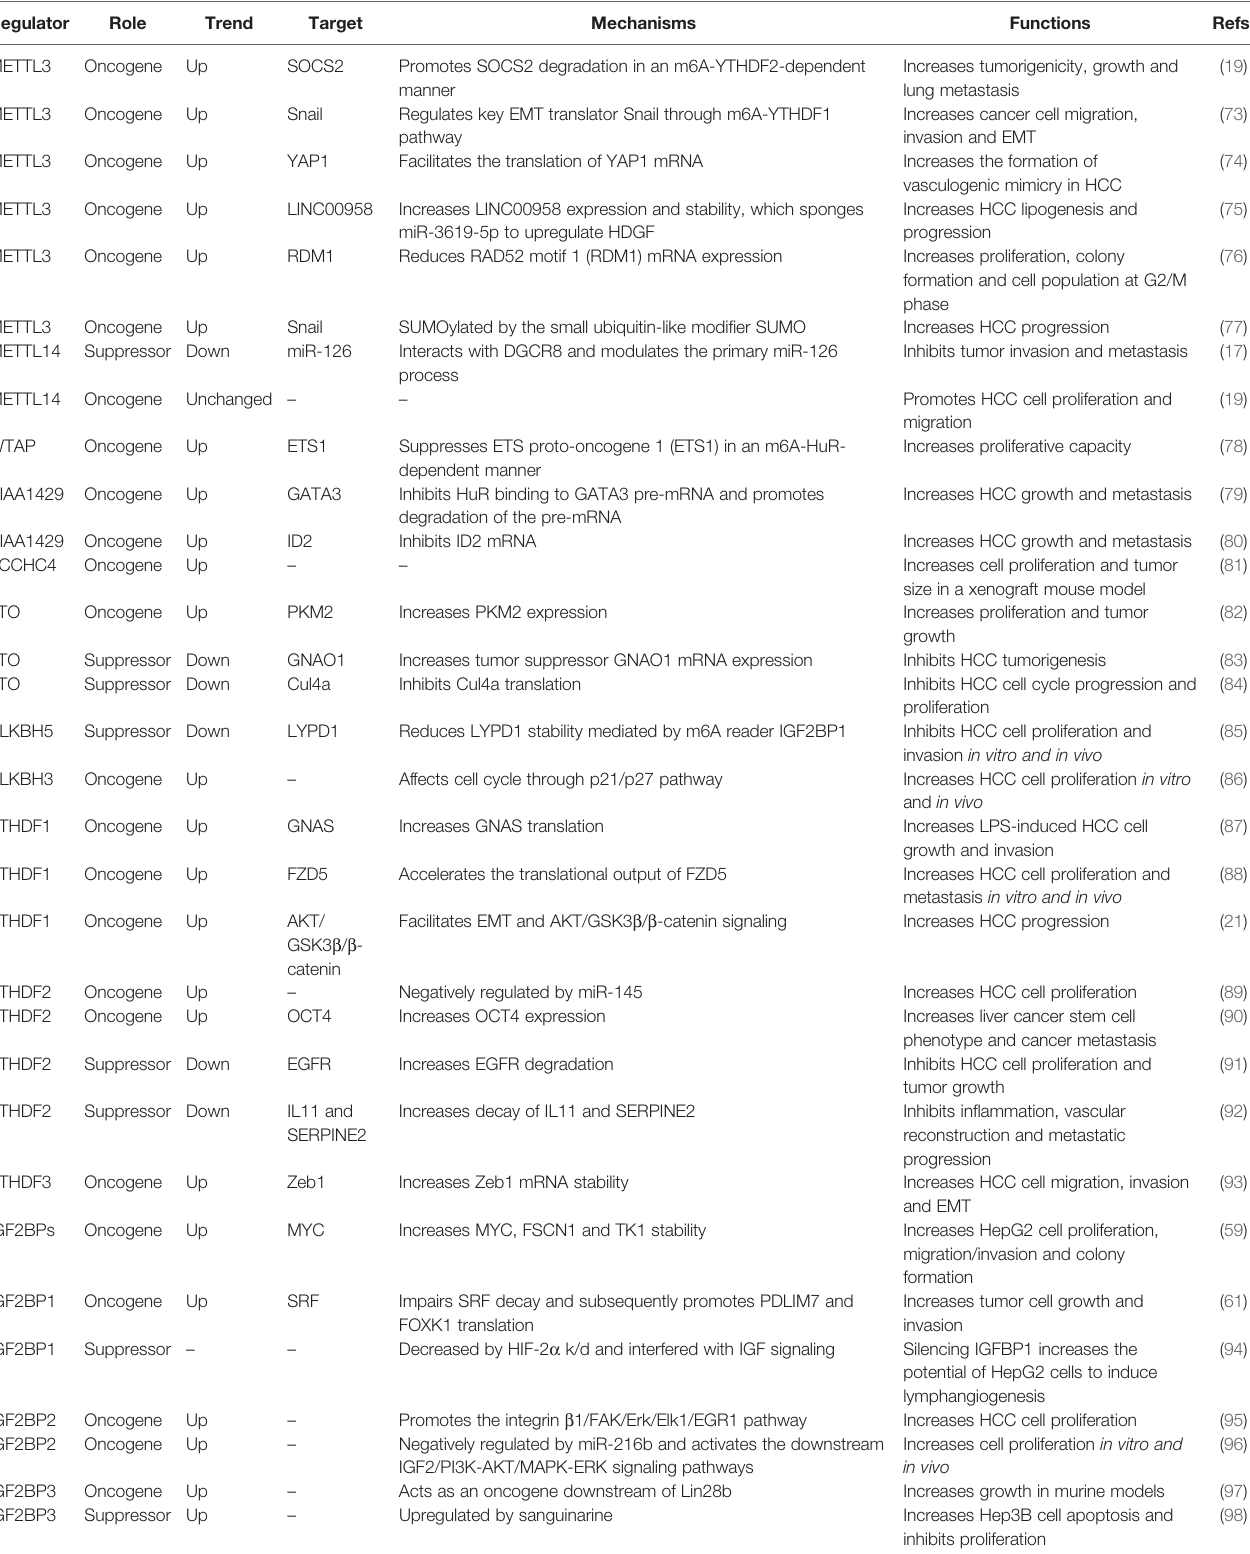
TABLE 2 | Roles of m 6 A-related regulators in